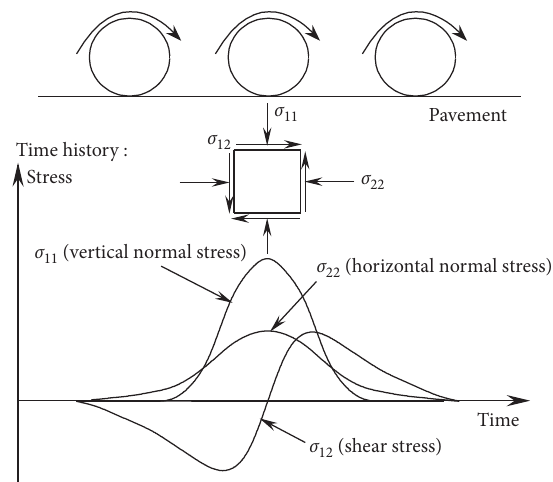
Figure 1: Variation of stress components induced by traffic